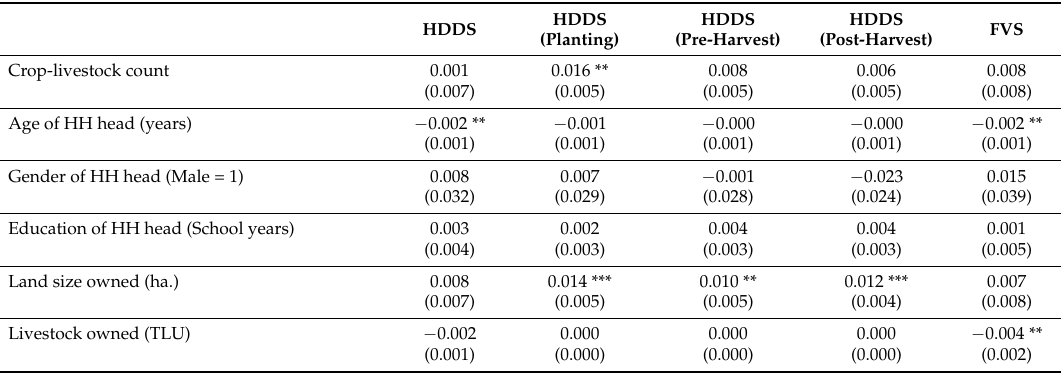
Table A3. Determinants of food consumption diversity in Kilosa (Production diversity indicator used: crop-livestock